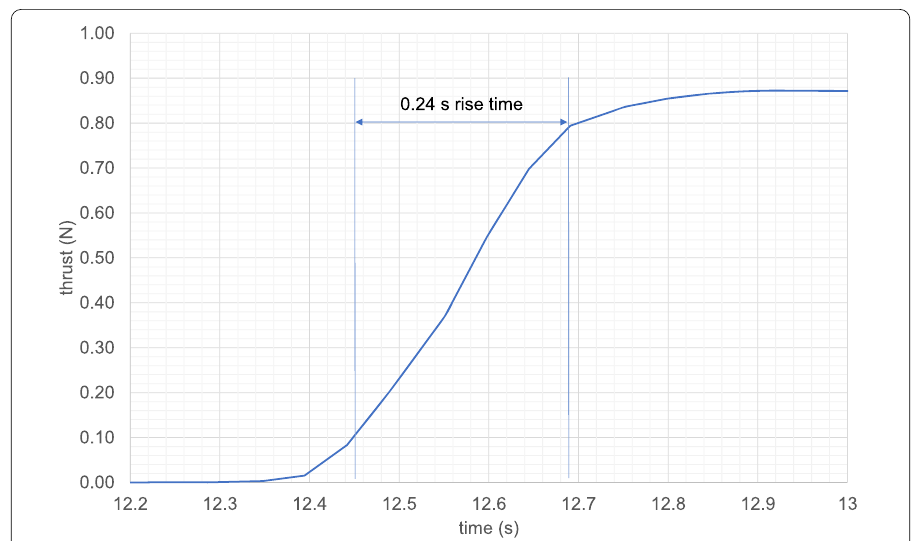
Figure 16 Determination of the rise time of the balance. The 10% to 90% rise time of the balance is 0.24 s